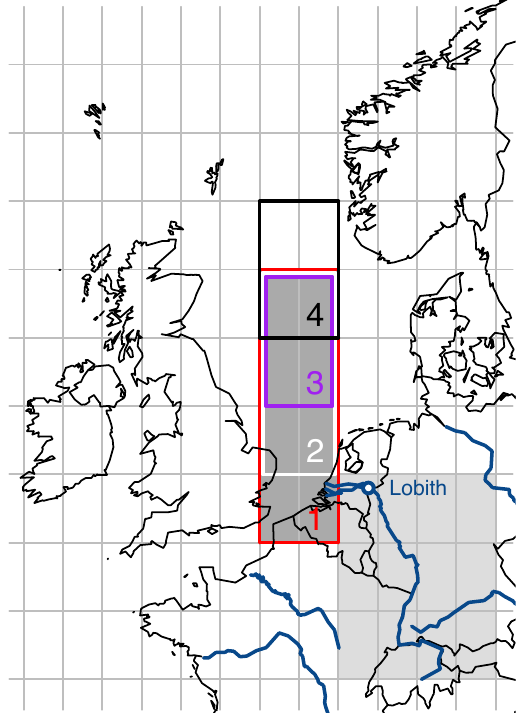
Fig. 1. ESSENCE grid cells selected to represent the Rhine basin (light grey shading) and assess the North Sea wind conditions favourable for surges (dark grey shading). Numbered boxes indi- cate the configurations used for sensitivity testing in Sect.